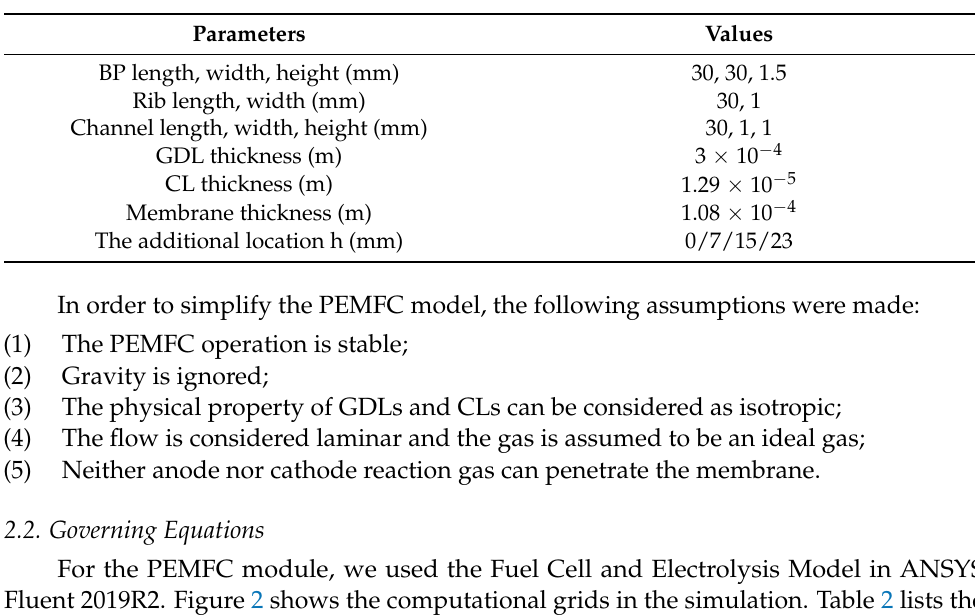
Table 1. The geometric parameters of each geometric component.